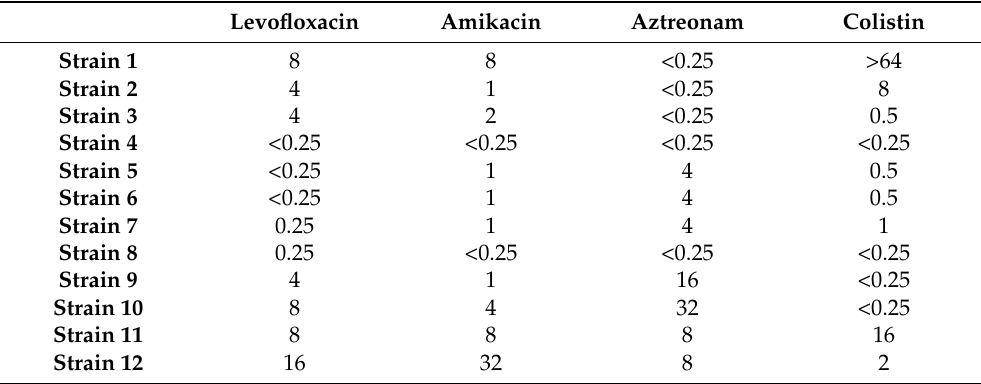
Table 1. MICs of levofloxacin, amikacin, aztreonam and colistin against P. aeruginosa strains isolated from patients with cystic fibrosis